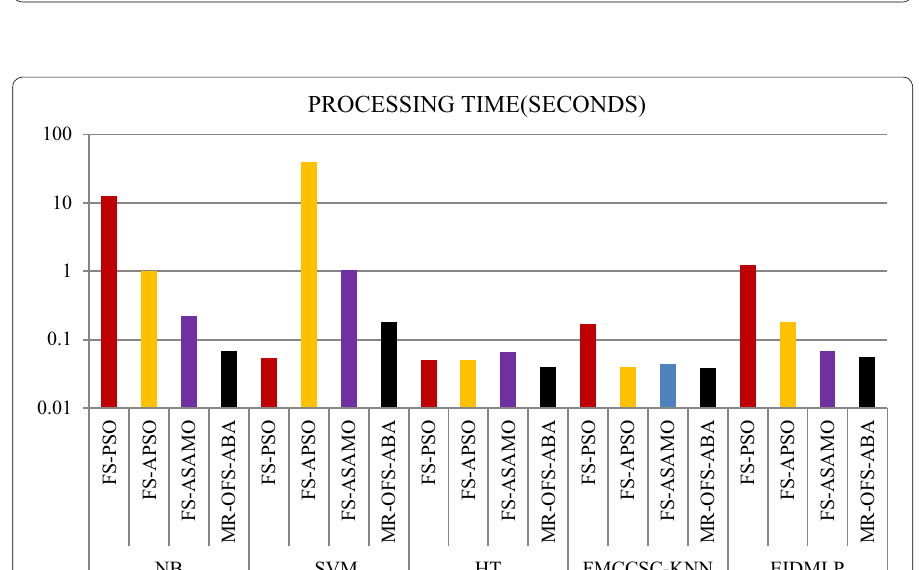
Fig. 6 Accuracy comparison